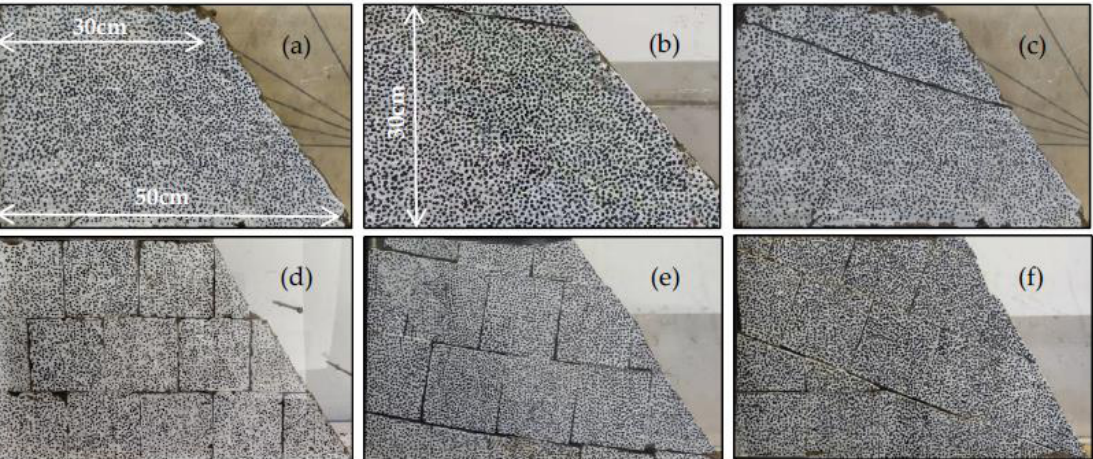
Figure 4. Slope model of expansive soil with different cracks without support. ( a ) No prefabricated crack; ( b ) one crack with an inclination of 10°; ( c ) one crack with an inclination of 20°; ( d ) horizontal crack networks; ( e ) crack networks with an inclination of 10°; ( f ) crack networks with an inclination of 20°.